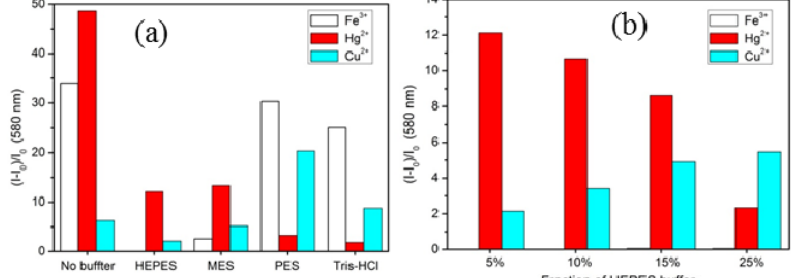
Figure 4. Fluorescence response of chemosensor 1 (5.0 μΜ , λ λ = 580 nm) ( a ) in CH CN/buffer (pH = 7.0) (95/5, v / v ) upon addition of 40 equiv of em 3 Fe 3+ , Hg 2+ , and Cu 2+ ions, respectively, and ( b ) in different fractions of HEPES buffer (0.02 M, pH = 7.0) upon addition of 40 equiv of Fe 3+ , Hg 2+ , and Cu 2+ ions, respectively. The responses for Fe 3+ are below 0.05 in the different fractions of HEPES